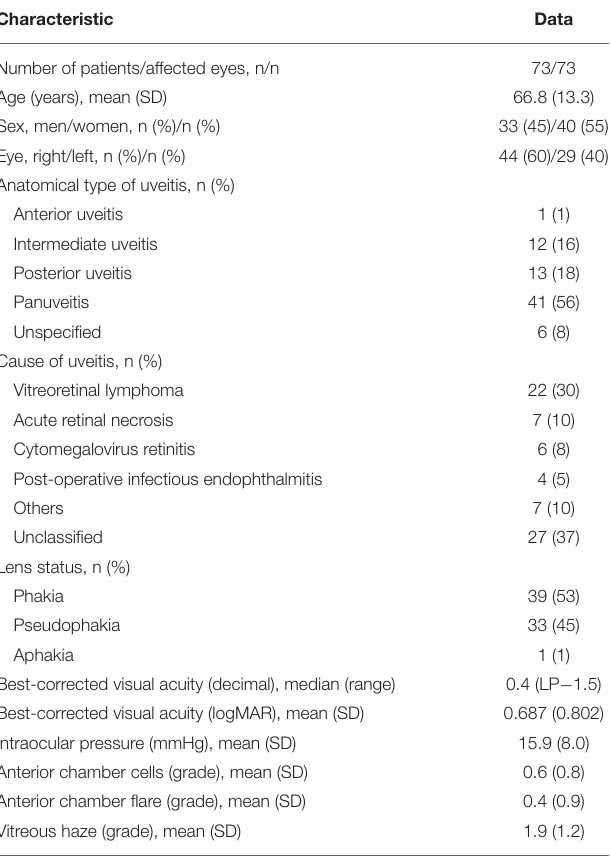
TABLE 1 | Pre-operative characteristics of the included patients.